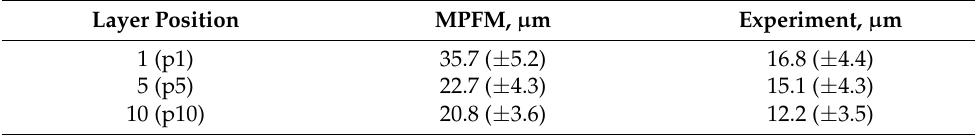
Table 6. Average PDASs from MPFM calculation and experimental